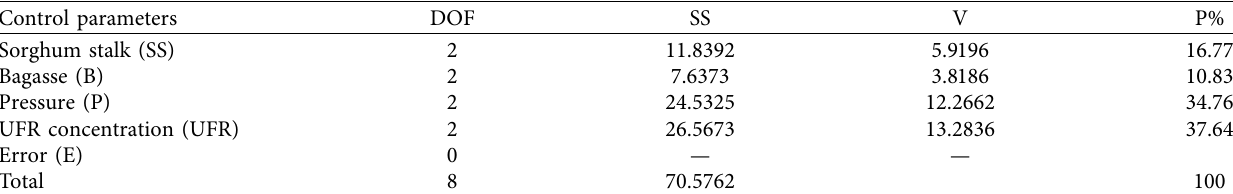
Table 12: ANOVA results for board moisture content (MC %).